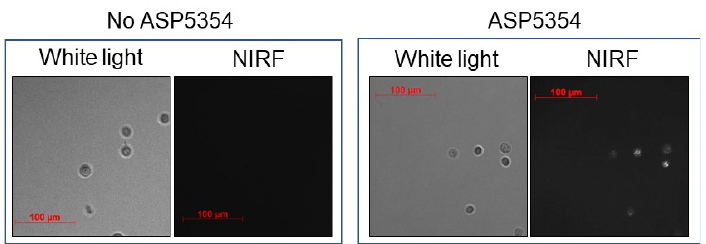
Figure 2. In vitro near-infrared fluorescence (NIRF) imaging of 24 μ M ASP5354 uptake to mouse MB49 bladder cancer cells. NIRF images of cells with 60-s exposure after 10-min incubation NIRF is displayed in white.